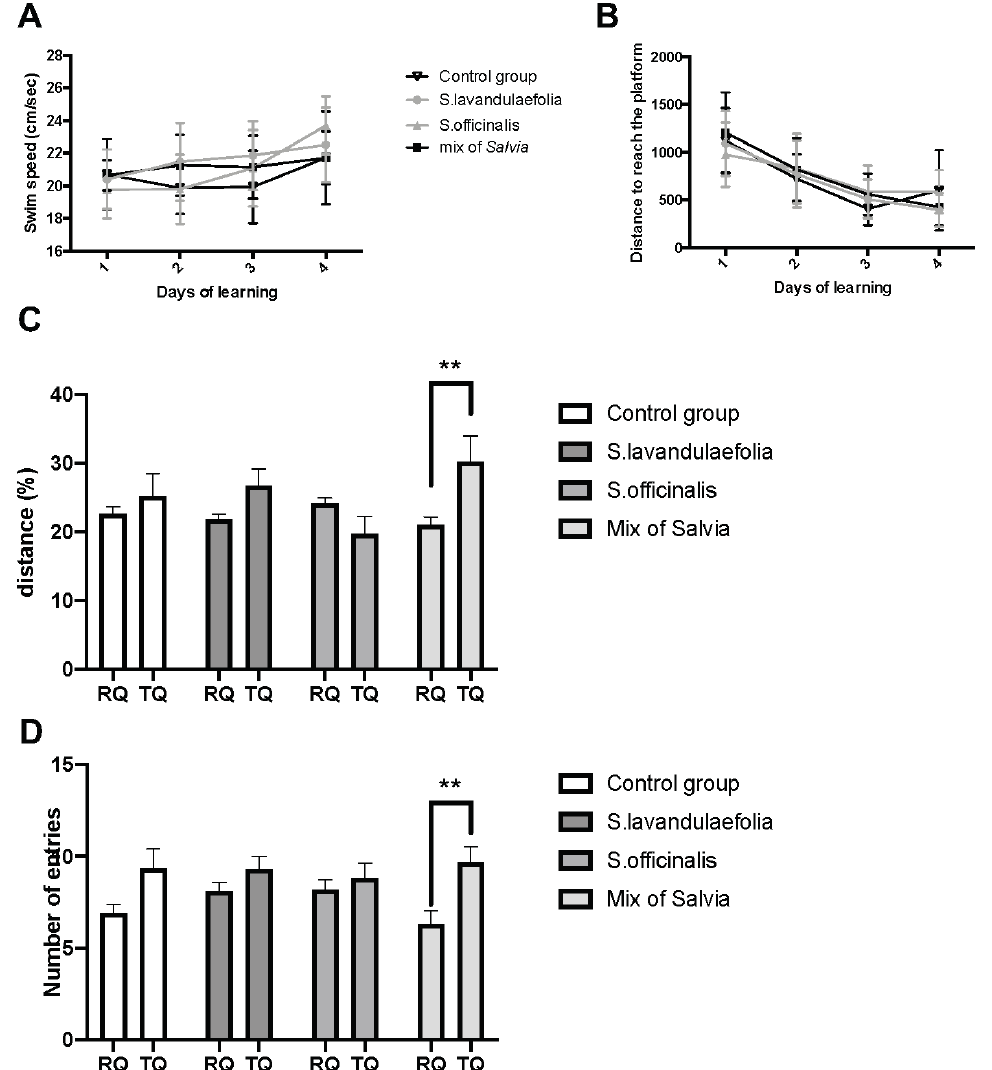
Figure 2. Chronic mix of Salvia supplementation improved long-term memory. Long-term memory performance was evaluated in the Morris water maze. ( A ) Swim speed during learning (day e ff ect: ** p < 0.01 by 2-way ANOVA; n = 10 per group). ( B ) Distance covered to reach the platform over the 4 consecutive days of spatial learning (day e ff ect p < 0.0001 by 2-way ANOVA with repeated